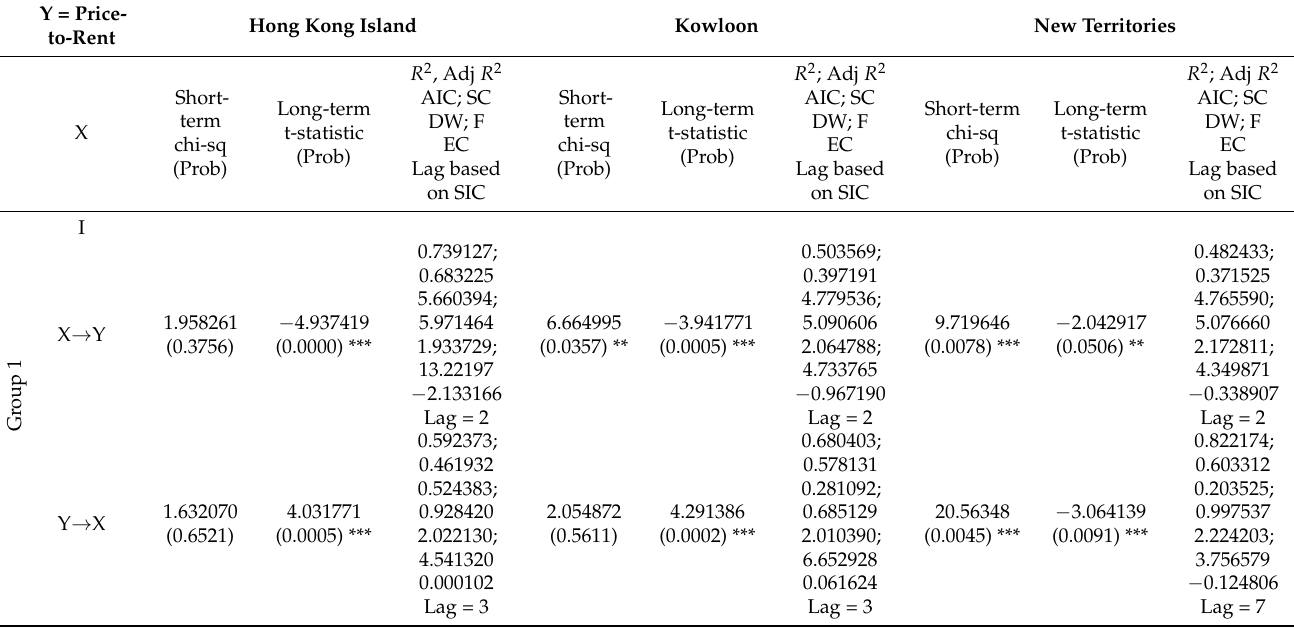
Table 4. Results of Granger causality